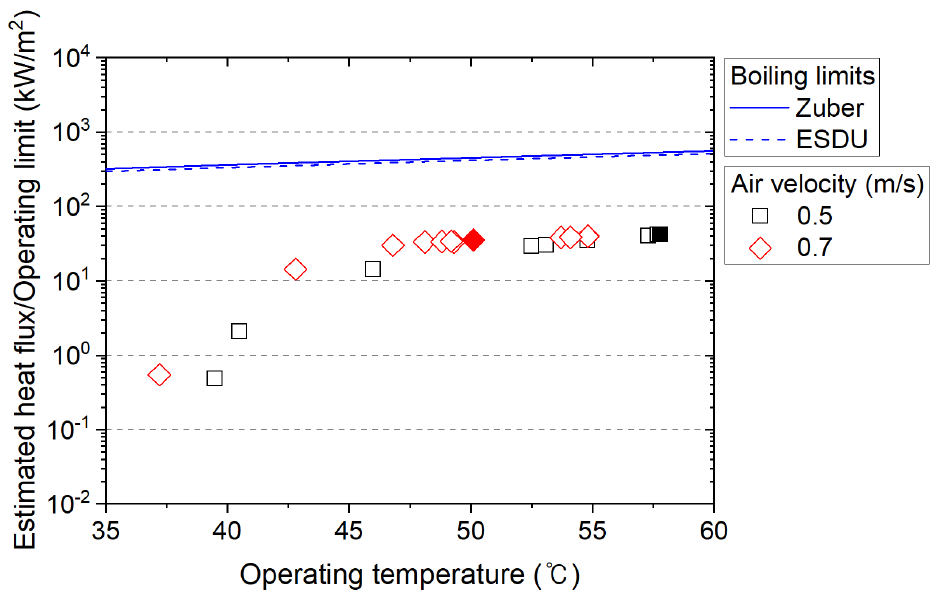
Figure 11. Comparison of the boiling limits and experimental data. The filled symbols indicate the maximum loop conductance data.